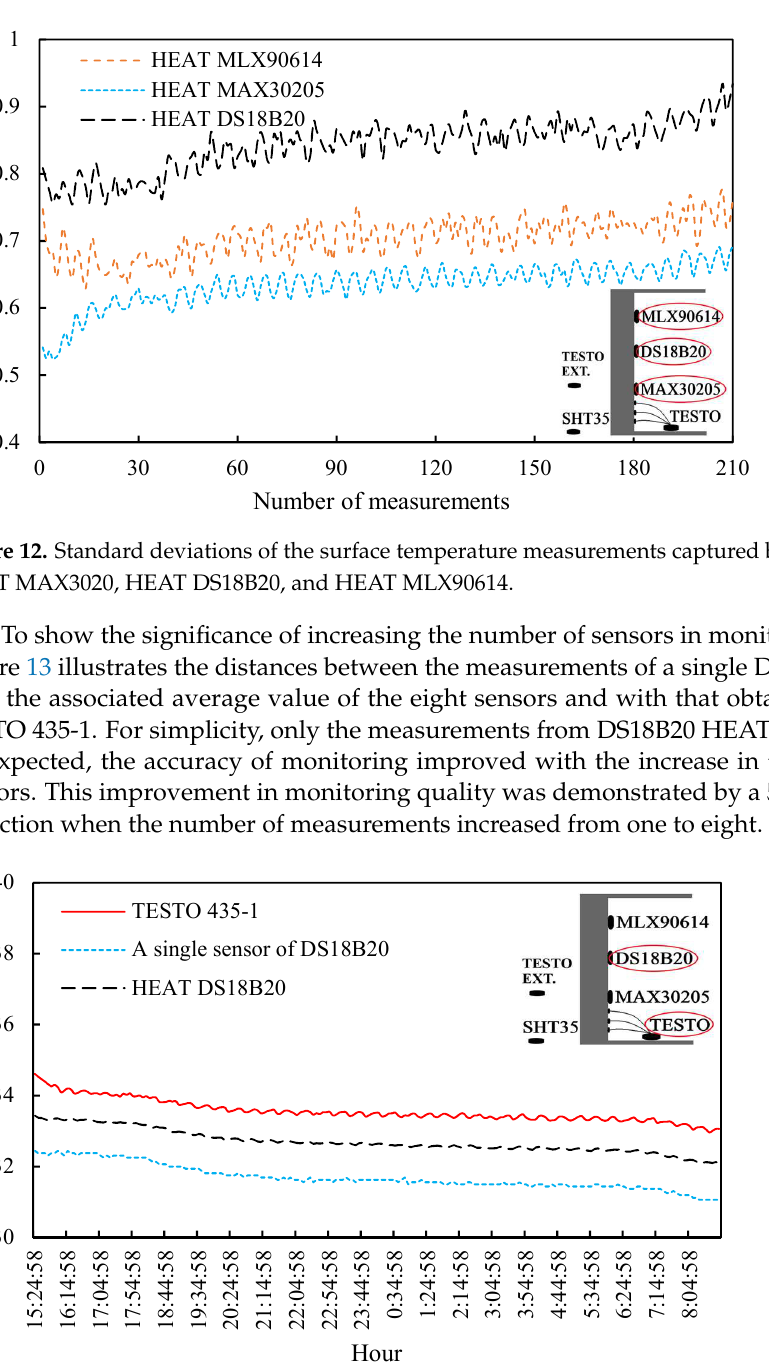
Figure 13. Comparison between indoor temperature measurements of TESTO 435-1 and that of a single sensor of DS18B20, and the associated average of the 8 sensors of DS18B20.